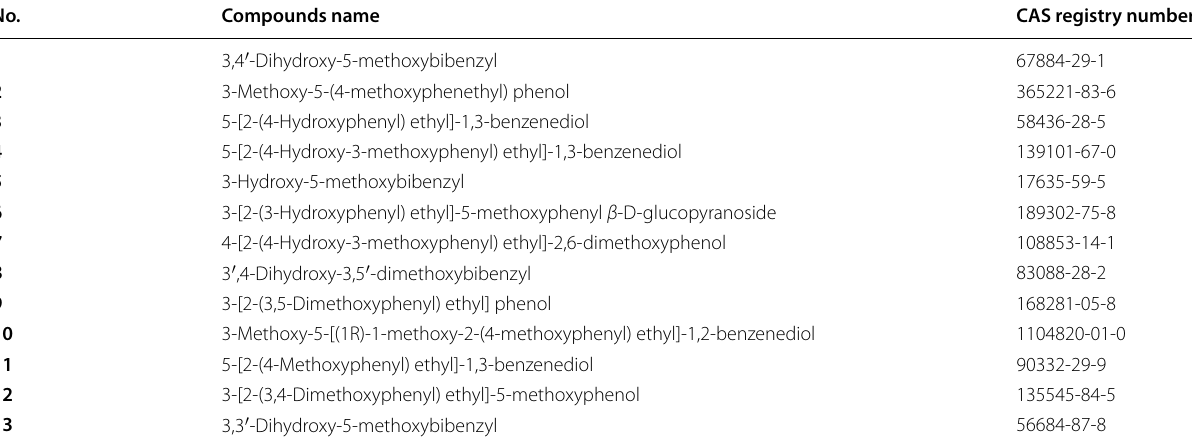
Table 2 The information of 13 bibenzyl derivatives in this study No.